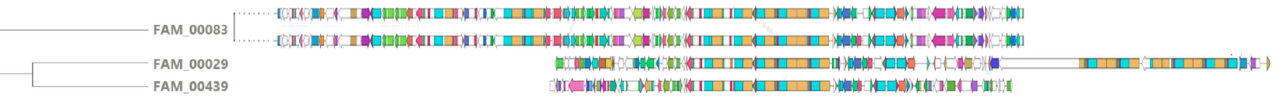
11 of 16 Figure 8. Biosynthetic gene clusters homologous to krb found in publicly available genomes. Surprisingly, the sandramycin BGC present in Kribbella sp. CA-293567 was not clus- tered with the two homologous pathways found in the K. sandramycini genomes (Figure 7), despite their high similarity. This may be caused by the fact that the sandramycin BGC antiSMASH prediction from K. sandramycini genomes includes more NRPS genes than those that are predicted in Kribella sp. CA-293567 in the same region. These superclusters, which are composed of subclusters with different biosynthetic features, are not properly resolved by antiSMASH, causing that BiG-SCAPE, which calculates BGC distances using